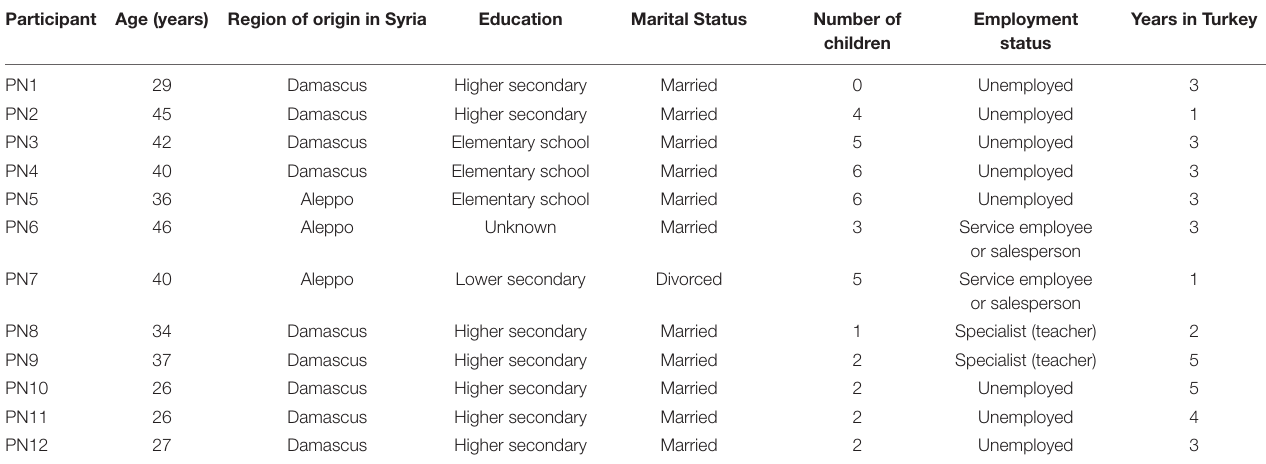
TABLE 2 | Demographic characteristics of participants (Study